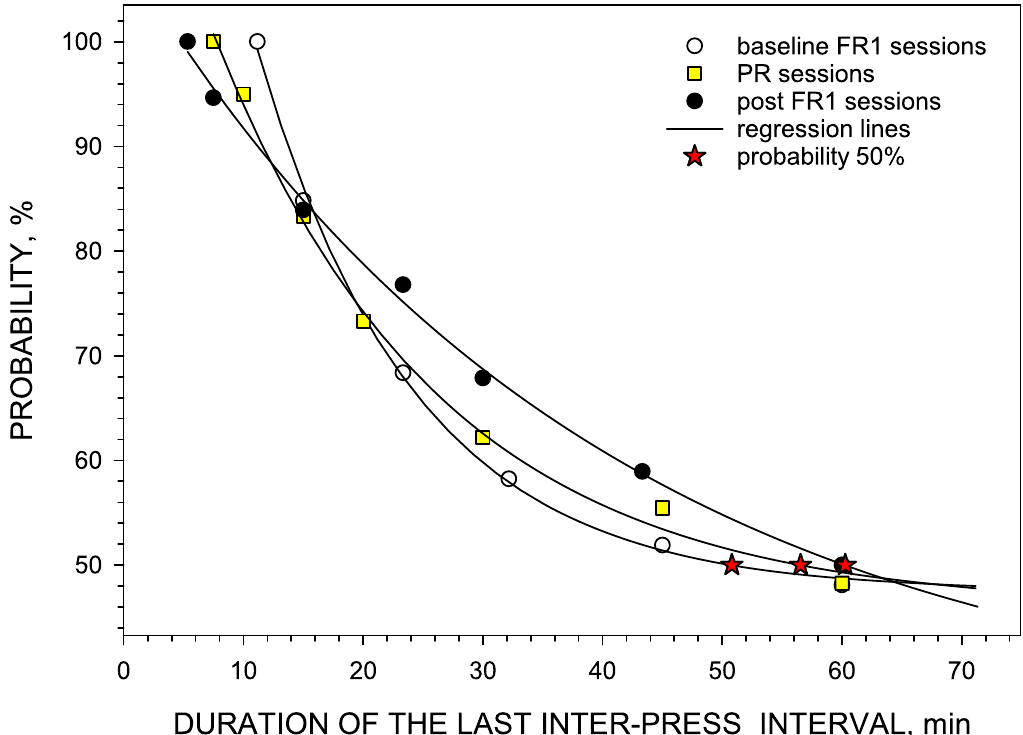
Figure 4. Survival analysis of the IPI after the last press defined according to the remission criteria for Baseline FR1 (11.2 min), PR sessions (7.5 min) and Post-PR FR1 (5.4 min). Symbols represent the time elapsed between the last unloading presses and the first remission press in Baseline FR1 sessions ( ○ ), PR sessions (yellow square) and Post-PR FR1 sessions ( ● ) in 6 rats. Lines represent the best fit of the nonlinear regression analyses according to y = y 0 + a ∙exp(– b ∙ x ) where y 0 = 47.5, a = 121.3, b = 0.08 for Baseline FR1, y 0 = 45.9, a = 81.6, b = 0.05 for PR sessions and y 0 = 33.7, a = 74.7, b = 0.03 for Post-PR FR1 sessions. Stars represent the 50% probability of that the first IPI ≥ remission criterion will be also longer than the following values: 50.8, 56.5 and 60.3 min for Baseline FR1, PR and Post-PR FR1 sessions, respectively. SigmaPlot v. 14.0 (https:// systa tsoft ware.